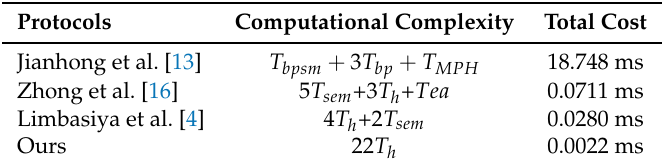
Table 3. Computation cost of key generation and message confirmation phase.